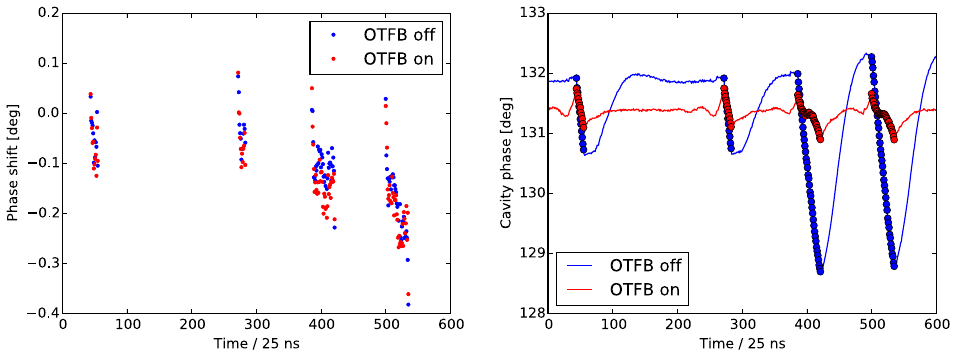
FIG. 18. Bunch-by-bunch phase shift (left) and cavity phase (right) with the one-turn feedback off (blue) and on (red). The circles on the right plot correspond to filled buckets. Beam 2. Fill 2248 (25 ns,